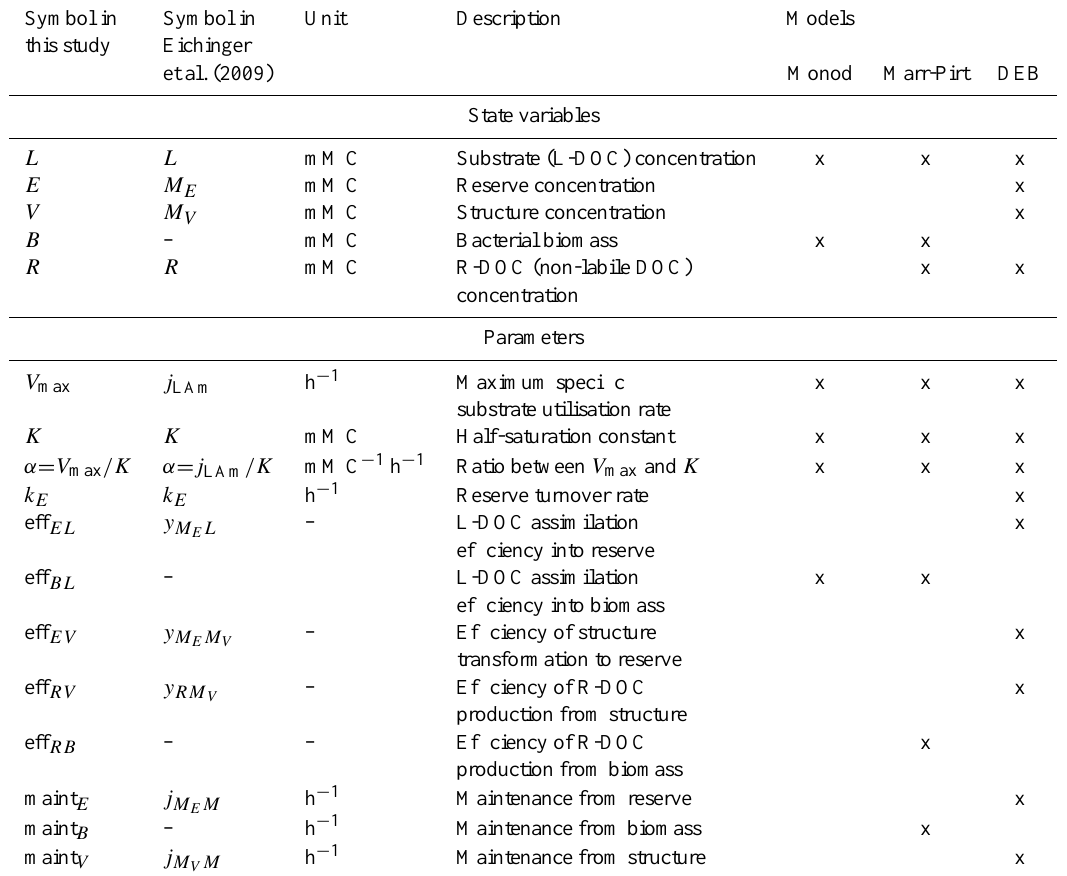
Table 1. Symbols, units and descriptions of notations, state variables and parameters used in each model. As we modified model notation of the DEB model from Eichinger et al. (2009), we also indicated its symbols in the paper describing its construction. Symbol